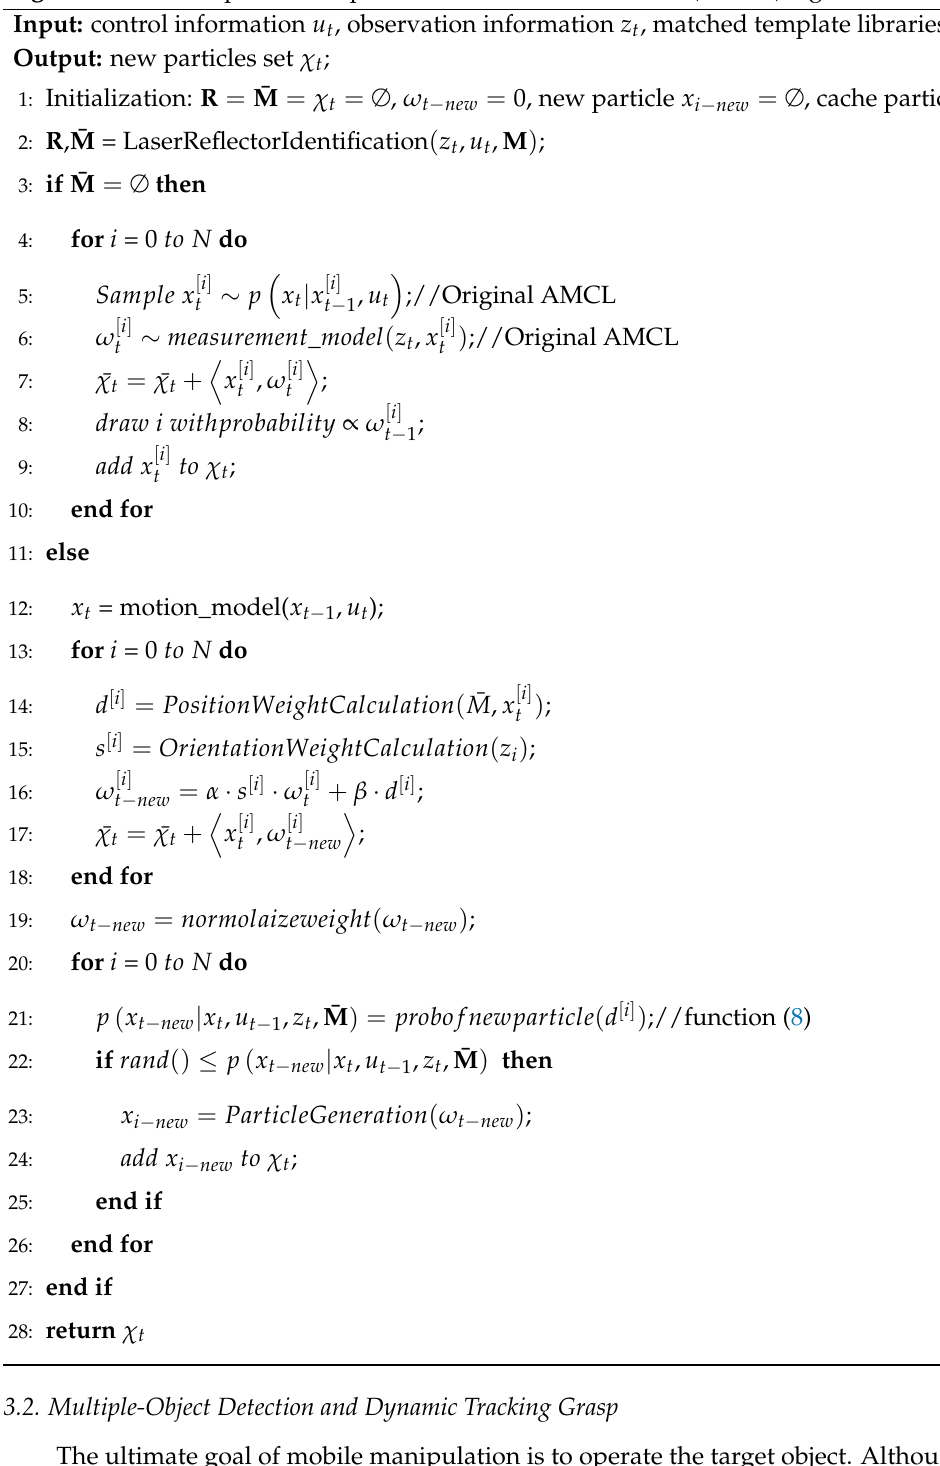
Algorithm 1 The improved adaptive Monte Carlo localization (AMCL)